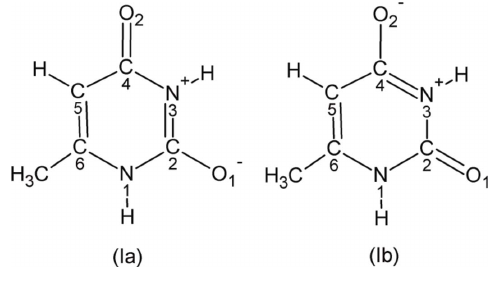
Figure 4 Polar canonical forms of 6Mura in form